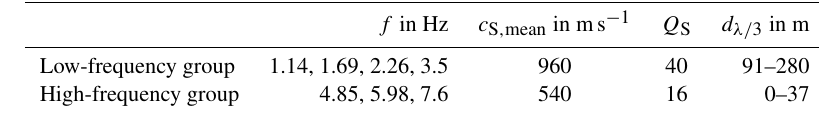
Table 2. Best model parameters ( c S and Q S ) to fit observed and calculated amplitude decays of low- and high-frequency signals. Depth d is estimated by assuming a surface wave penetration depth of λ/ 3.